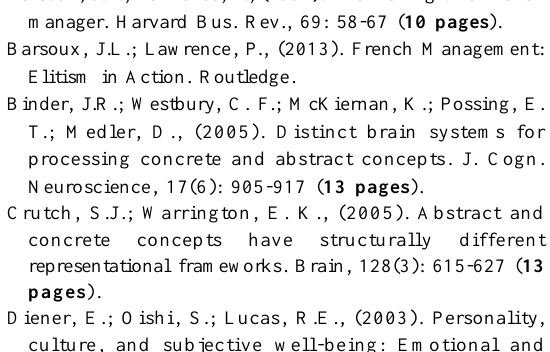
representational frameworks. Brain, 128(3): 615-627 (